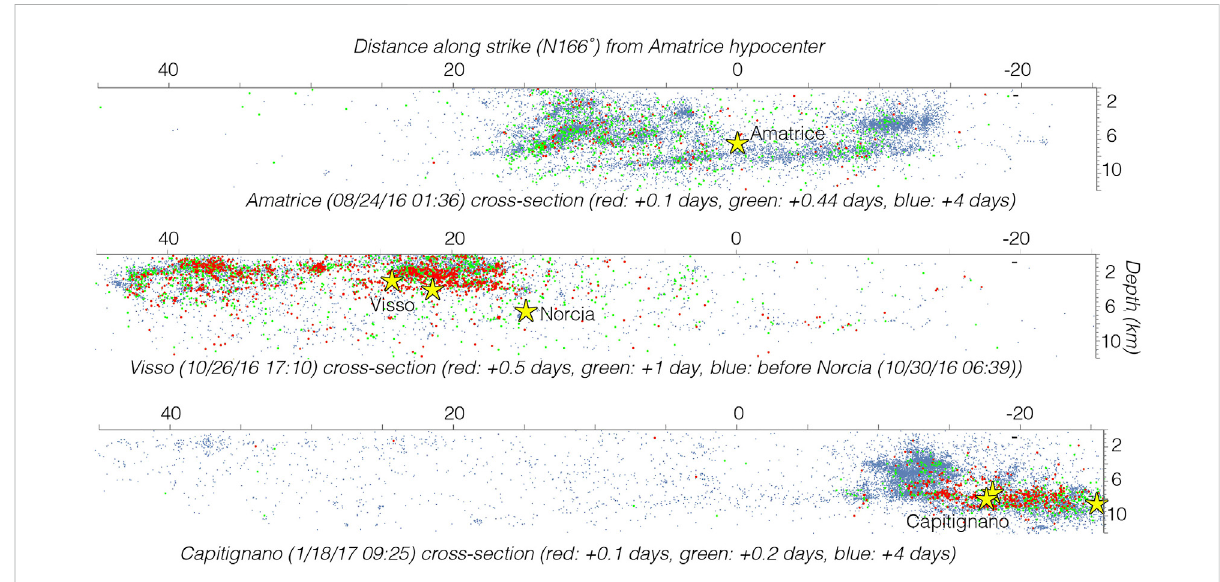
FIGURE 11 Cross-sectional views of relocated catalogs. Relocated earthquake catalogs of the Central Apennines seismic sequence (Tan et al., 2021). The top panel shows an eastward view that highlights a basal detachment at ~10 – 15 km depth as well as several structures above it. Red events correspond to the fi rst 0.1 days after the Amatrice mainshock and to the fi rst two diffusion curves in Figure 8, and the green dots include all three diffusion events; these earthquakes highlight potential fl uid diffusion pathways along faults. The red events in the center panel correspond in timewiththepotentialdiffusionevent betweentheVissoandNorciashocks(Figure 9).Thelowerpanel showspotentialdiffusionpathwaysinvolving the Capitignano sequence of 4 M ≥ 5 shocks (Figure